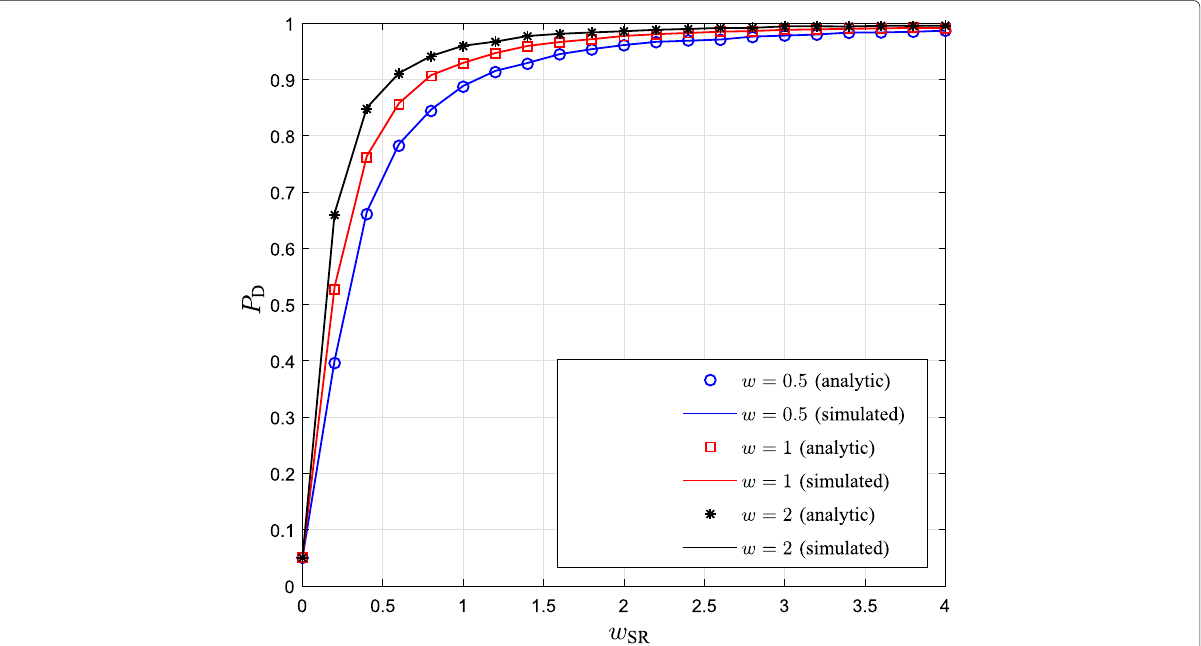
Fig. 7 P D performance for different source-relay-destination